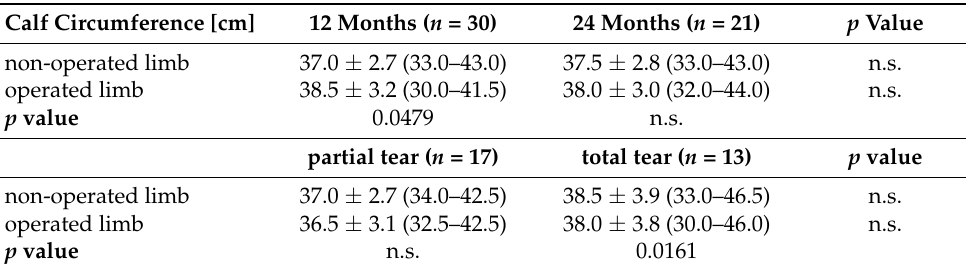
Table 2. Clinical evaluation of calf